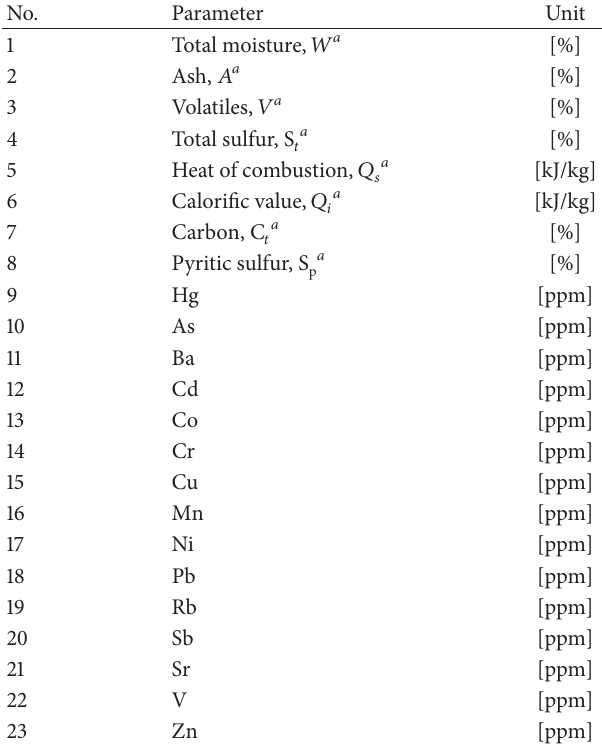
Table 4: Parameters of hard coal samples of the Upper Silesian Coal Basin (USCB) analyzed with